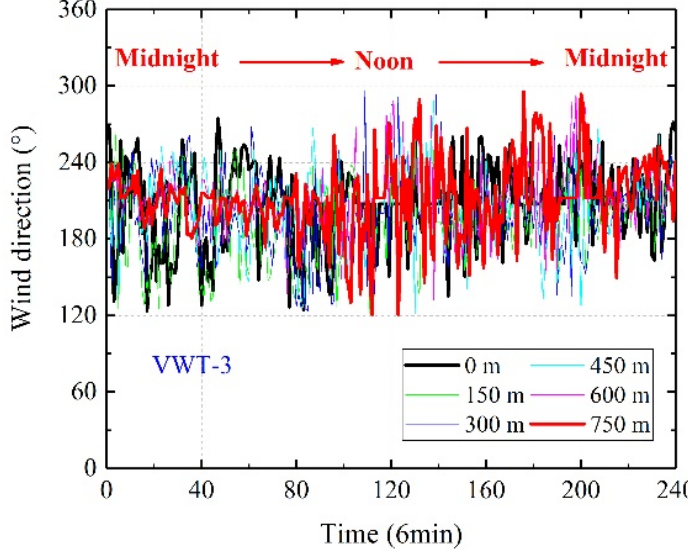
Figure 14. Time history of wind direction.